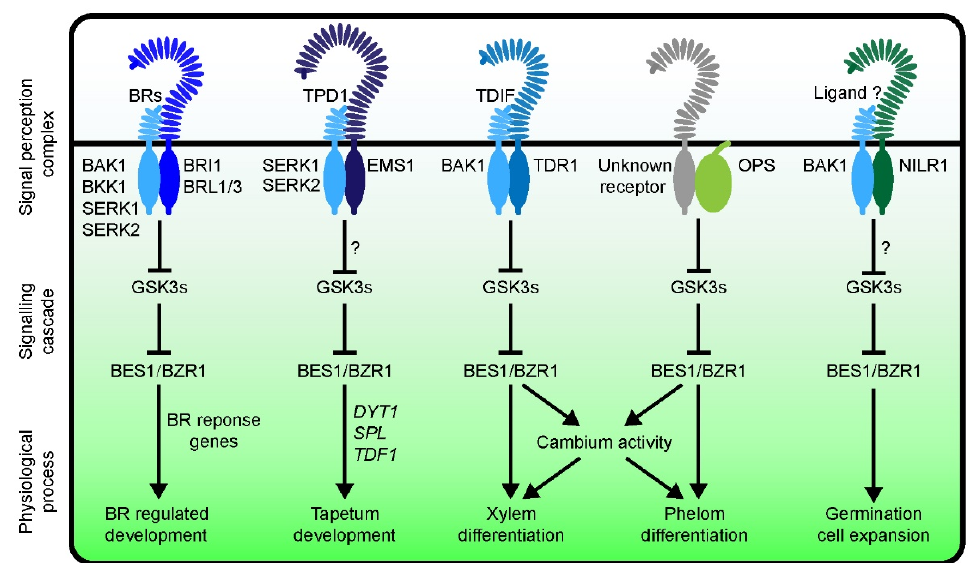
Figure 3. A current model showing BES1/BZR1 family members are involved in several signal pathways. In a classical BR signaling pathway, BRI1-BR-BAK1 regulates gene expression mainly via the BES1/BZR1 transcription factors family, which have been well characterized within the past two- and-a-half decades. Genetic and biochemical analyses indicated that the EMS1-TPD1-SERK1/SERK2 regulates tapetum development through activating BES1 and its paralogs. BES1 and BZR1 directly regulate the expression of tapetum developmental genes, such as SPL , DYT1 , and TDF1 . The TDR- TDIF-BAK1 signaling pathway regulates xylem cell differentiation via BES1/BZR1 family members. A plasma membrane-associated OPS regulates phloem differentiation via activating BES1. However, it is unclear whether there is an undefined RLK which can interact with OPS. NILR1 plays a role in seed germination and cell expansion. Co-receptor BAK1 is shared by NILR1, and down- stream components may also be the same as those in the BRI1-BR-BAK1 signaling pathway. Question marks represent unconfirmed steps.